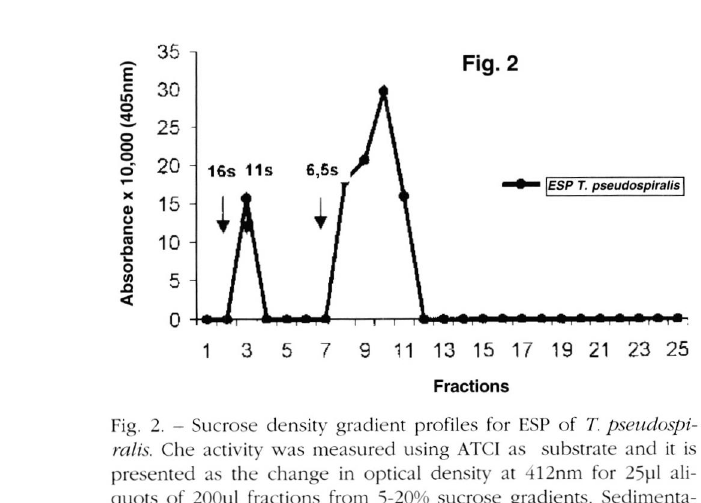
Fig. 2. - Sucrose density gradient profiles for F.SP of T. pseudospi ralis. Che activity was measured using ATCI as substrate and it is presented as the change in optical density at 4l2nm for 25pl ali- quots of 200pl fractions from 5-20% sucrose gradients. Sedimenta­ tion coefficients were determined by comparison with standards: b- galactosidase (16S), catalase (11S) and alkaline phosphatase (6 .1S).